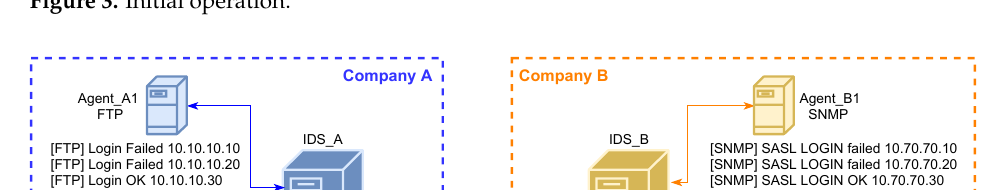
Figure 3. Initial operation.